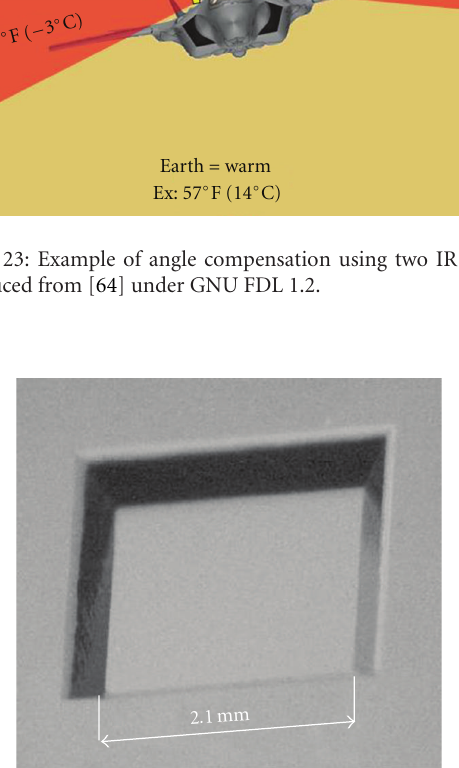
during indoor missions where this kind of IR tracking works poorly because the IR radiation signals are more or less unpredictable.